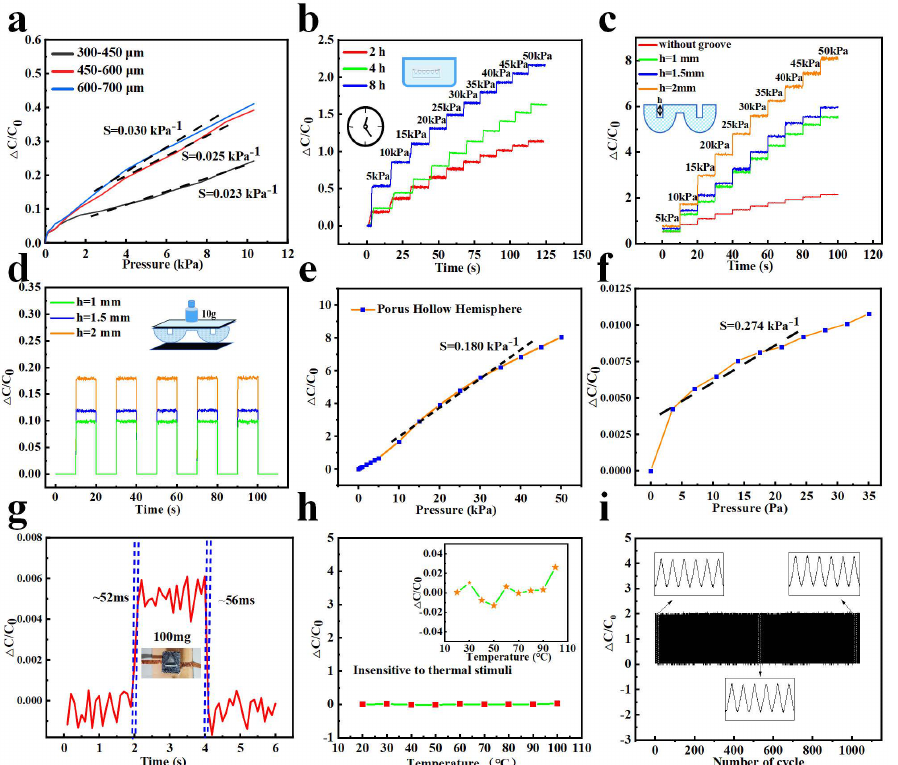
Figure 3. Performance tests of the fabricated sensors. ( a ) The dynamic response of ∆ C/C 0 for the porous hemisphere capacitive sensor based on the salt particles with different diameters (300–450 µ m, 450–600 µ m, and 600–700 µ m). ( b ) The corresponding ∆ C/C 0 for the porous sensors immersed in water for different times (2 h, 4 h, and 8 h). ( c ) The capacitance responses of the pressure sensor based on different groove depths under step-loading pressure circumstances. ( d ) Relative changes in capacitance versus time plots of the PHHDL-based capacitive pressure sensor with varied groove depth under repeated pressure of 350 Pa exerted by a weight of 10 g. ( e , f ) Pressure-response curves for the optimized fabricated PHHDL-based sensor. ( g ) Relation and steady-state curve of the pressure sensor with loading and unloading of a weight of 100 mg. ( h ) The stability curve of the flexible pressure sensor with increased temperature. ( i ) Endurance capacitance changes over 1000 cycles at 12 kPa.